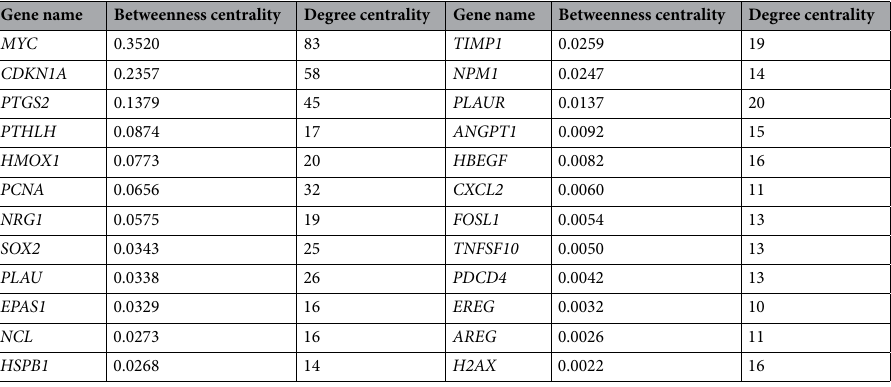
Table 2. Centrality information of selected